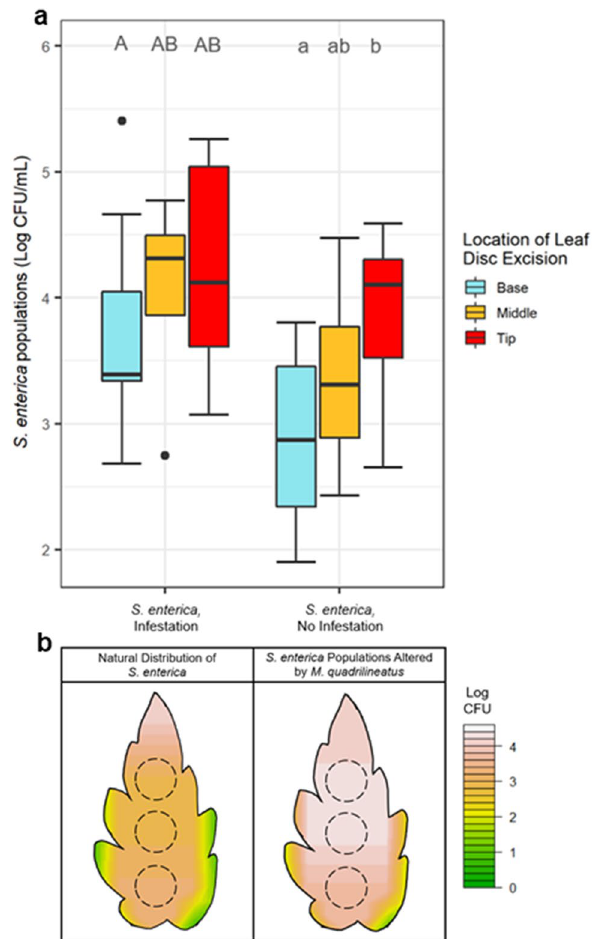
Figure 4. Adult M. quadrilineatus infestation on S. enterica inoculated tomato plants resulted in a redistribution of bacterial populations. In the absence of insects, S. enterica populations are significantly higher at the tips of leaflets ( P < 0.05); however, after insect infestation, S. enterica populations are approximately uniform across the tip and middle ( a , b ) regions. The 2 X 2 factorial experiment included S. enterica or water inoculated plants that were either infested, or not infested by M. quadrilineatus . Empty clip cages were applied for treatment groups with no infestation. Leaf discs were excised from the tip, middle and basal regions of leaflets. Salmonella enterica populations were also measured on water inoculated leaves but yielded 0 CFU, and were thus excluded from the figure. An interpolation graph was created to depict the shift in bacterial populations (Log CFU) over a 72 h post-infestation period. Singular dots represent an outlier point. Letters above boxplots indicate significant differences between leaf treatment groups within an insect infestation treatment ( P < 0.05), as detected by a one- way